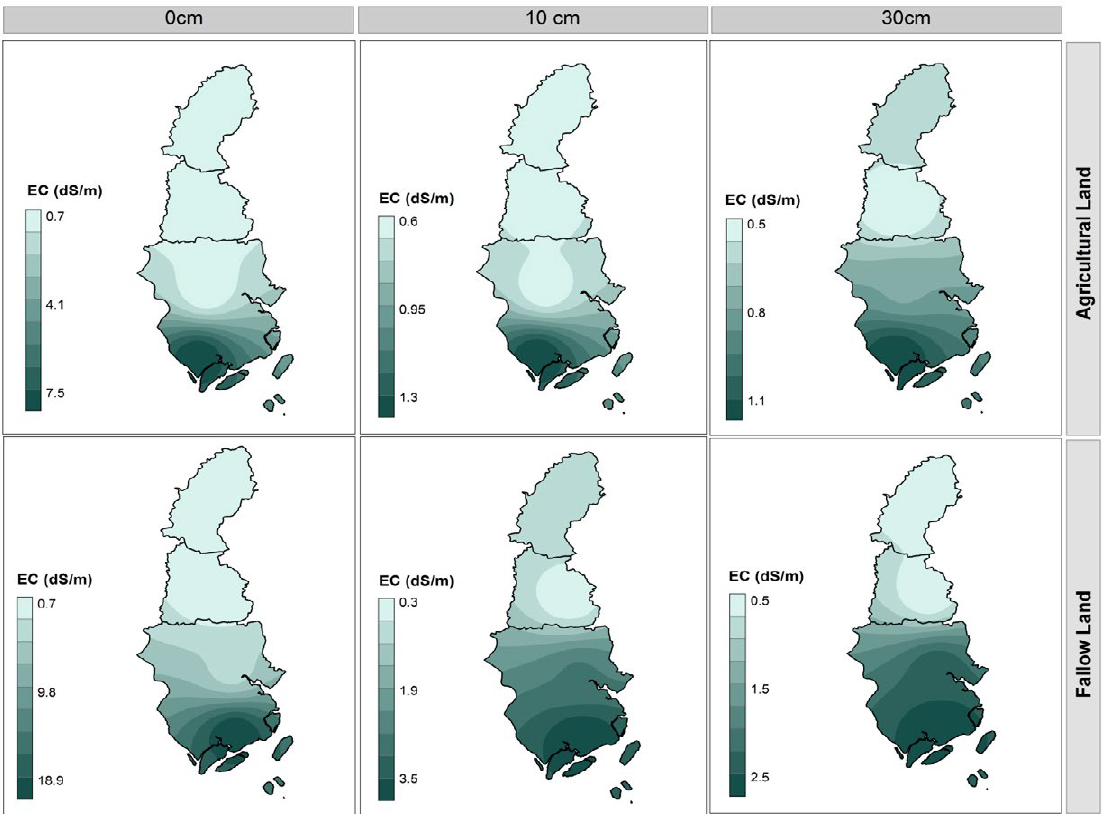
Fig. 4: Trends of Electric Conductivity (dS/m) along with the distances